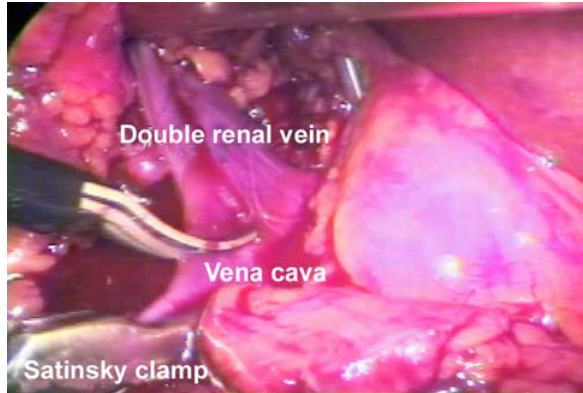
Figure 6 – Two titanium clips are placed and the renal vein is sectioned close to the vena cava.